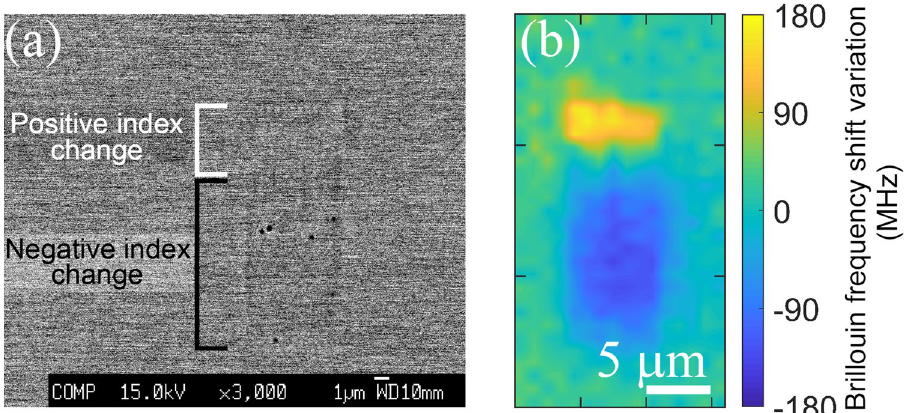
mode dimensions were 17.5 × 23.2 μm in comparison to the 11.5 μm input fiber mode at 3.1 μm. Considering the refractive index matching between the fiber and the waveguide this produced a net coupling loss of 1.37 dB/